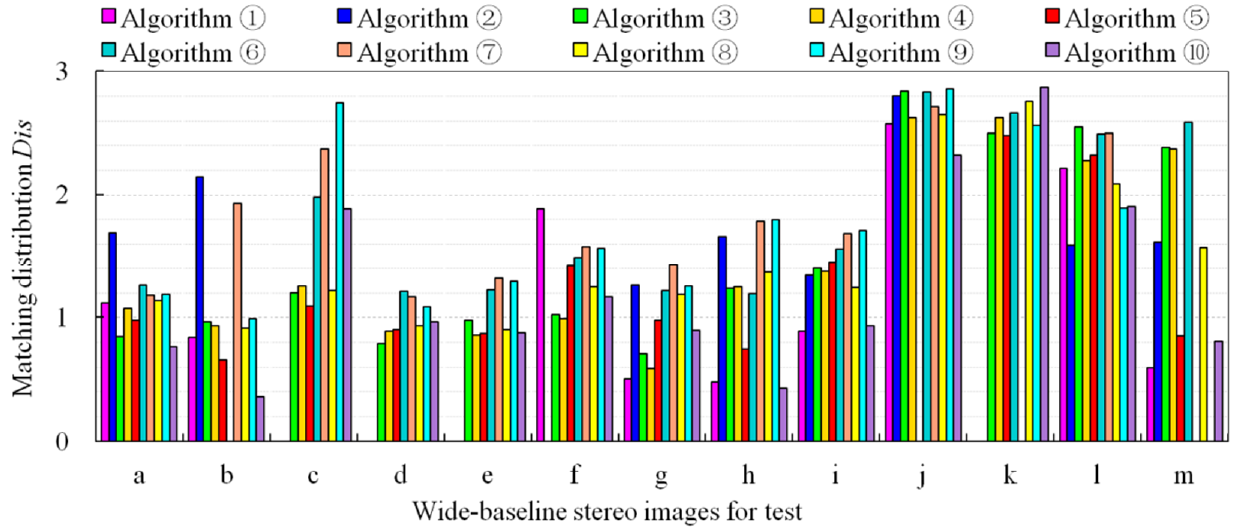
Figure 12. Comparison of the matching distribution quality of the ten algorithms.